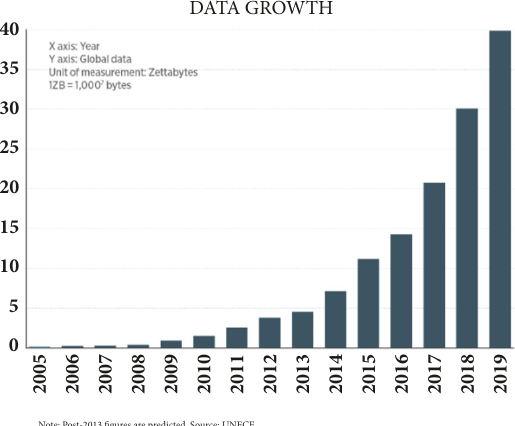
Figure 1: The network data growth. Source UNECE.